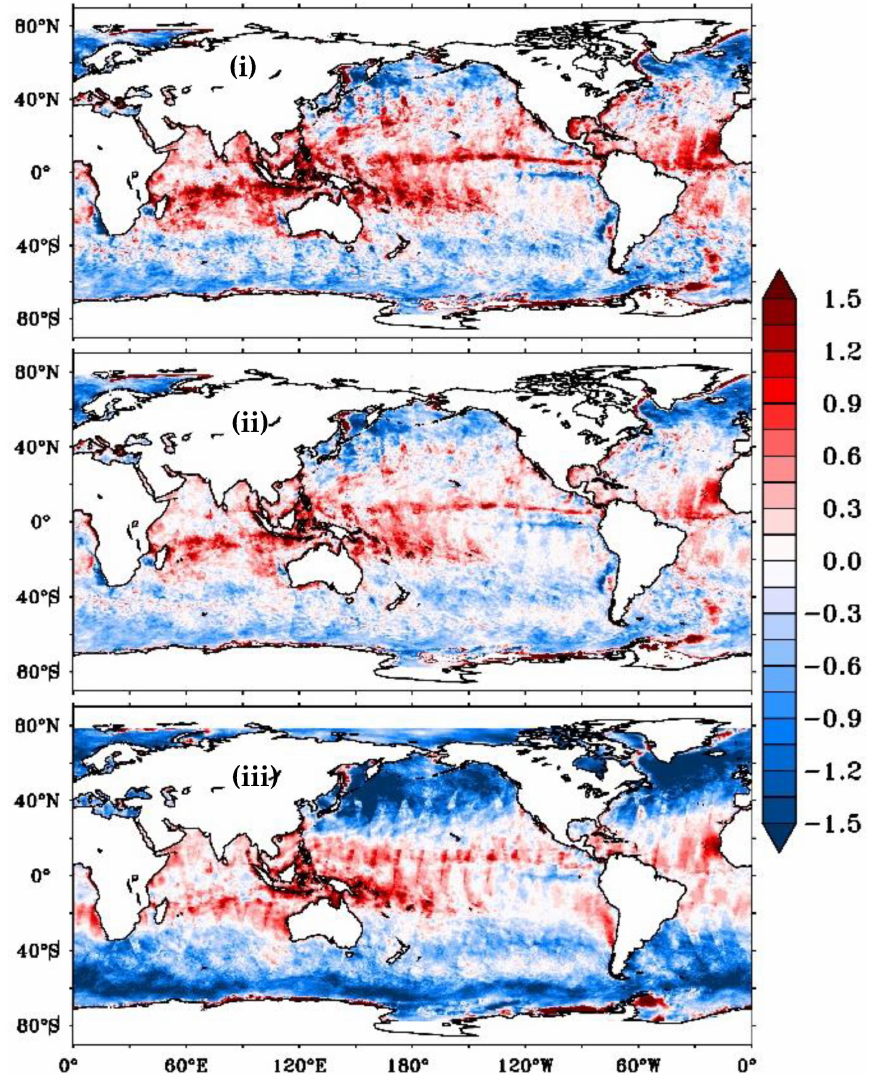
Figure 8. The spatial distribution of bias in wind speed (m/s) between CCMP wind speed and ( i ) SCATSAT-1 L2B wind speed (top panel), ( ii ) Particle filter based reanalysed wind speed (middle panel) ( iii ) SCATSAT-1 L4AW wind speed (bottom panel) during January